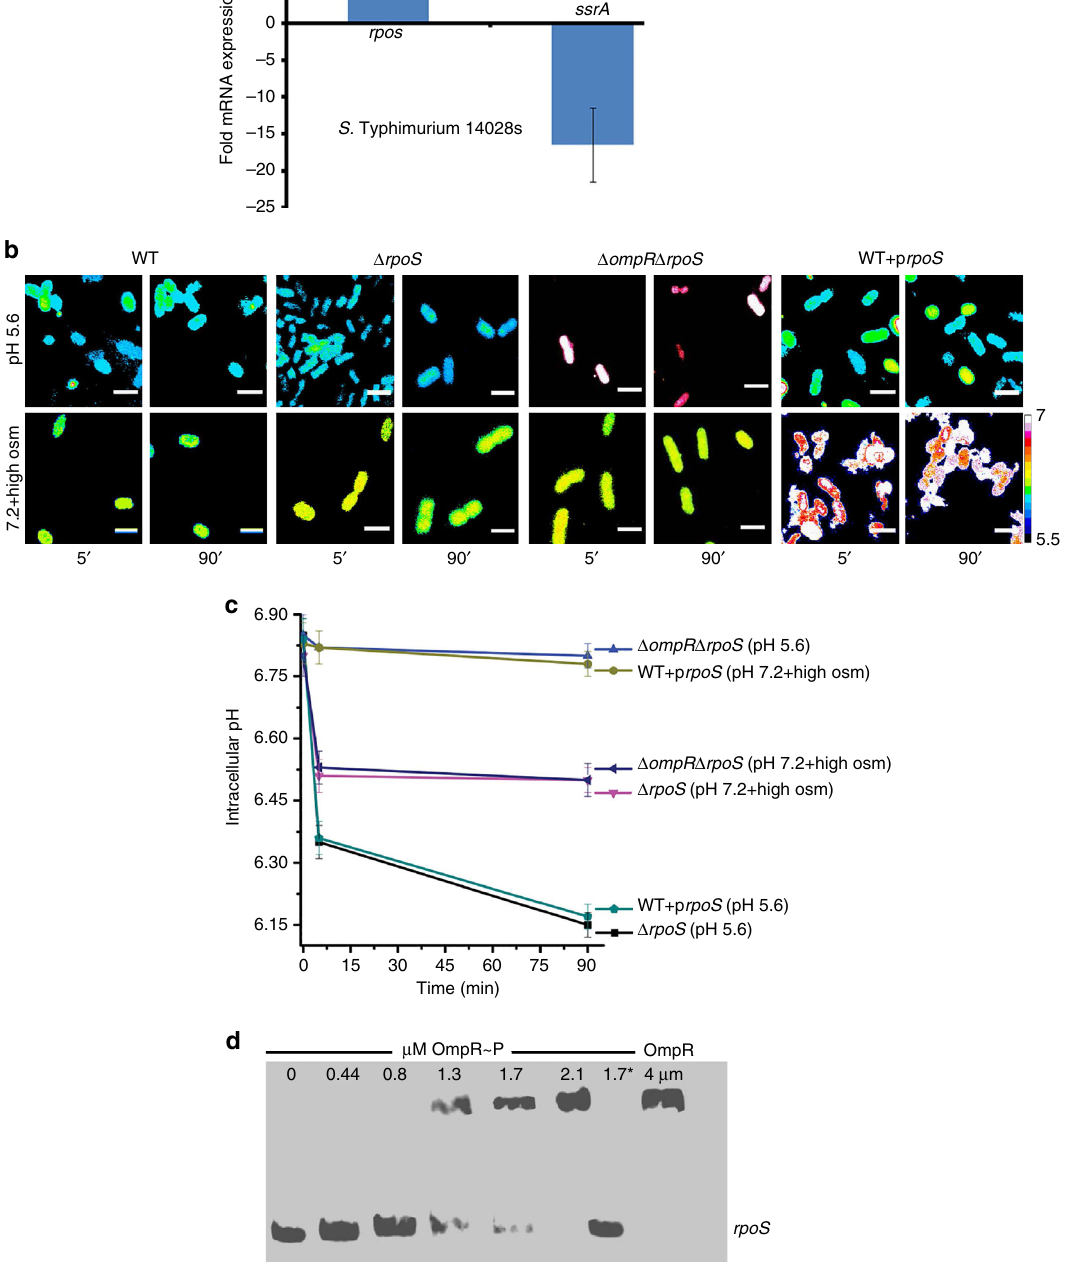
Fig. 2 Osmotic stress acidi fi es S. Typhimurium via OmpR repression of rpoS . a mRNA levels of rpos and ssrA (a positive control) genes were determined by qRT-PCR from wild-type and ompR null strains of S . Typhimurium grown at high osmolality. Fold expression changes in the ompR null strain was compared to the wild-type level and plotted. The error bars represent the mean ± s.d. ( n = 6). In the ompR null strain, rpoS transcription was increased, suggesting OmpR repression. b Representative images of R 488/440 are shown after 5 and 90min incubation at pH e 7.2 or pH e 7.2 in the presence of 15% (w/v) sucrose (high osm) of wild type, an ompR / rpoS null strain, an rpoS null strain, and an rpoS over-expressed strain of S . Typhimurium. Scale bar, 3 μ m. c A plot from 50 cells of the R 488/440 ratios of various mutants of S . Typhimurium at indicated times. Symbols represent the mean ± s.e.m. ( n = 3). d An EMSA examined the interaction between OmpR and rpoS . OmpR was incubated with 10 fmol of biotin end-labeled rpoS . Lane 1.7* contained 100-fold excess unlabeled near-neutral pH i , decreasing by < 0.1 pH unit to 6.75 (Fig. 1a, b). acidify during osmotic stress, indicating that EnvZ is actually functioning as a pH sensor. Using sucrose as the osmolyte, A similar decrease was evident in E. coli , where osmotic stress − 1 addition of 15% sucrose (w/v; 787 mOsm Kg reduced the pH i from 7.13 to 6.75. The pH i of the ompR null E. ) to the medium at pH e 7.2 led to a decrease in the pH i of S . Typhimurium from 6.80 coli strain did not decrease in response to sucrose-induced to 6.45 (Fig. 1a, b). In contrast, the ompR null strain remained osmotic stress and remained at pH i 7.1 (Fig. 1c, d). Thus, in both